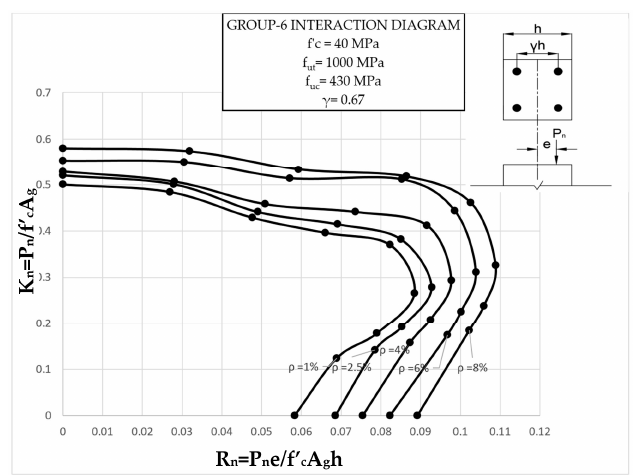
Figure 18. Group 6 interaction diagram.